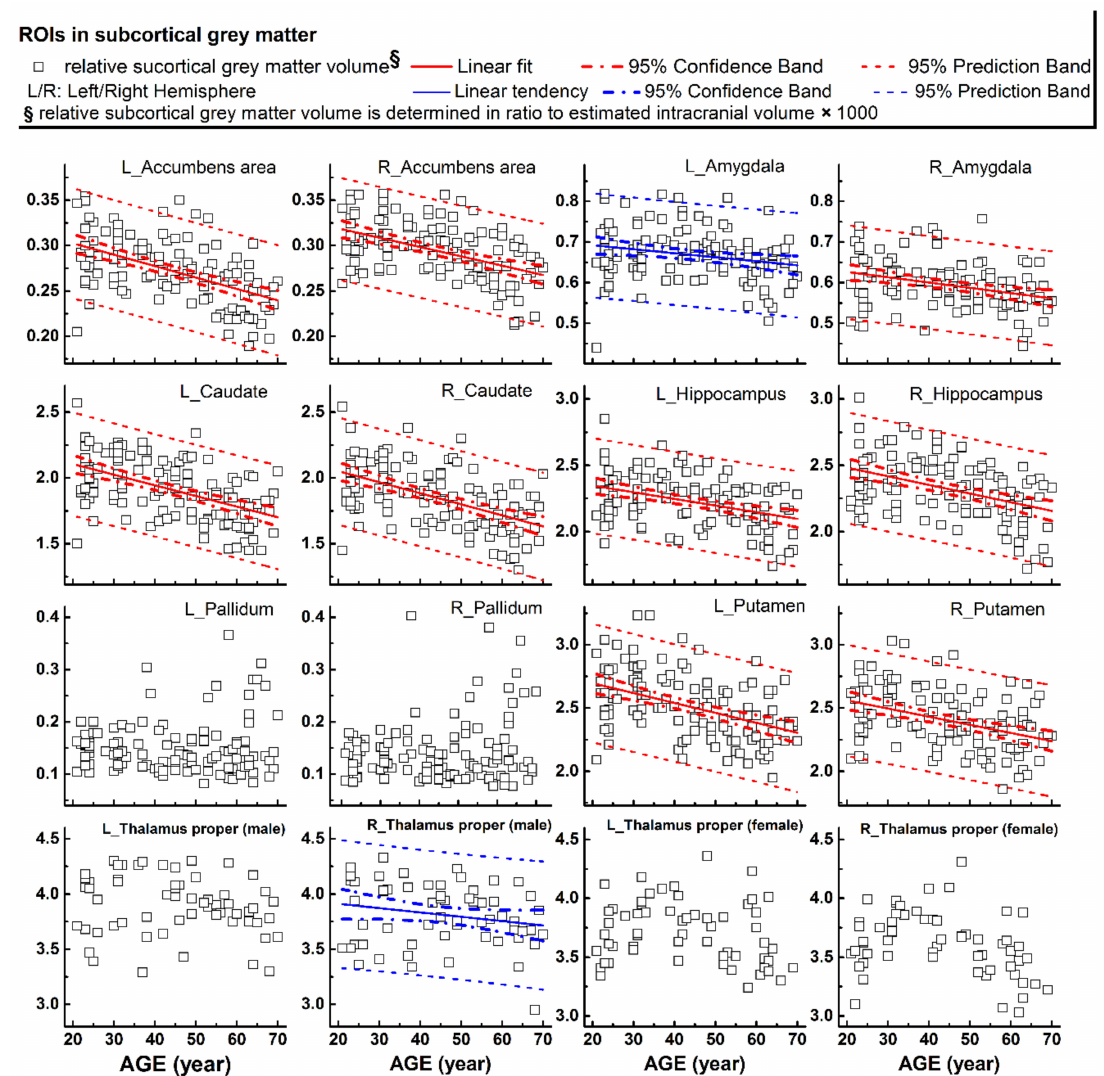
Figure 2. Relative volumes ( y -axis) measured from subcortical grey matter structures plotted versus age ( x -axis). Corre- sponding linear fits, the calculated 95% confidence interval bands, and the 95% prediction interval bands were also shown in 11 ROIs, where a significant ( p < 0.004, 9 ROIs with red lines) or a trend of nearly significant (0.004 < p < 0.05, 2 ROIs with blue lines) correlation between the measured values and the age was